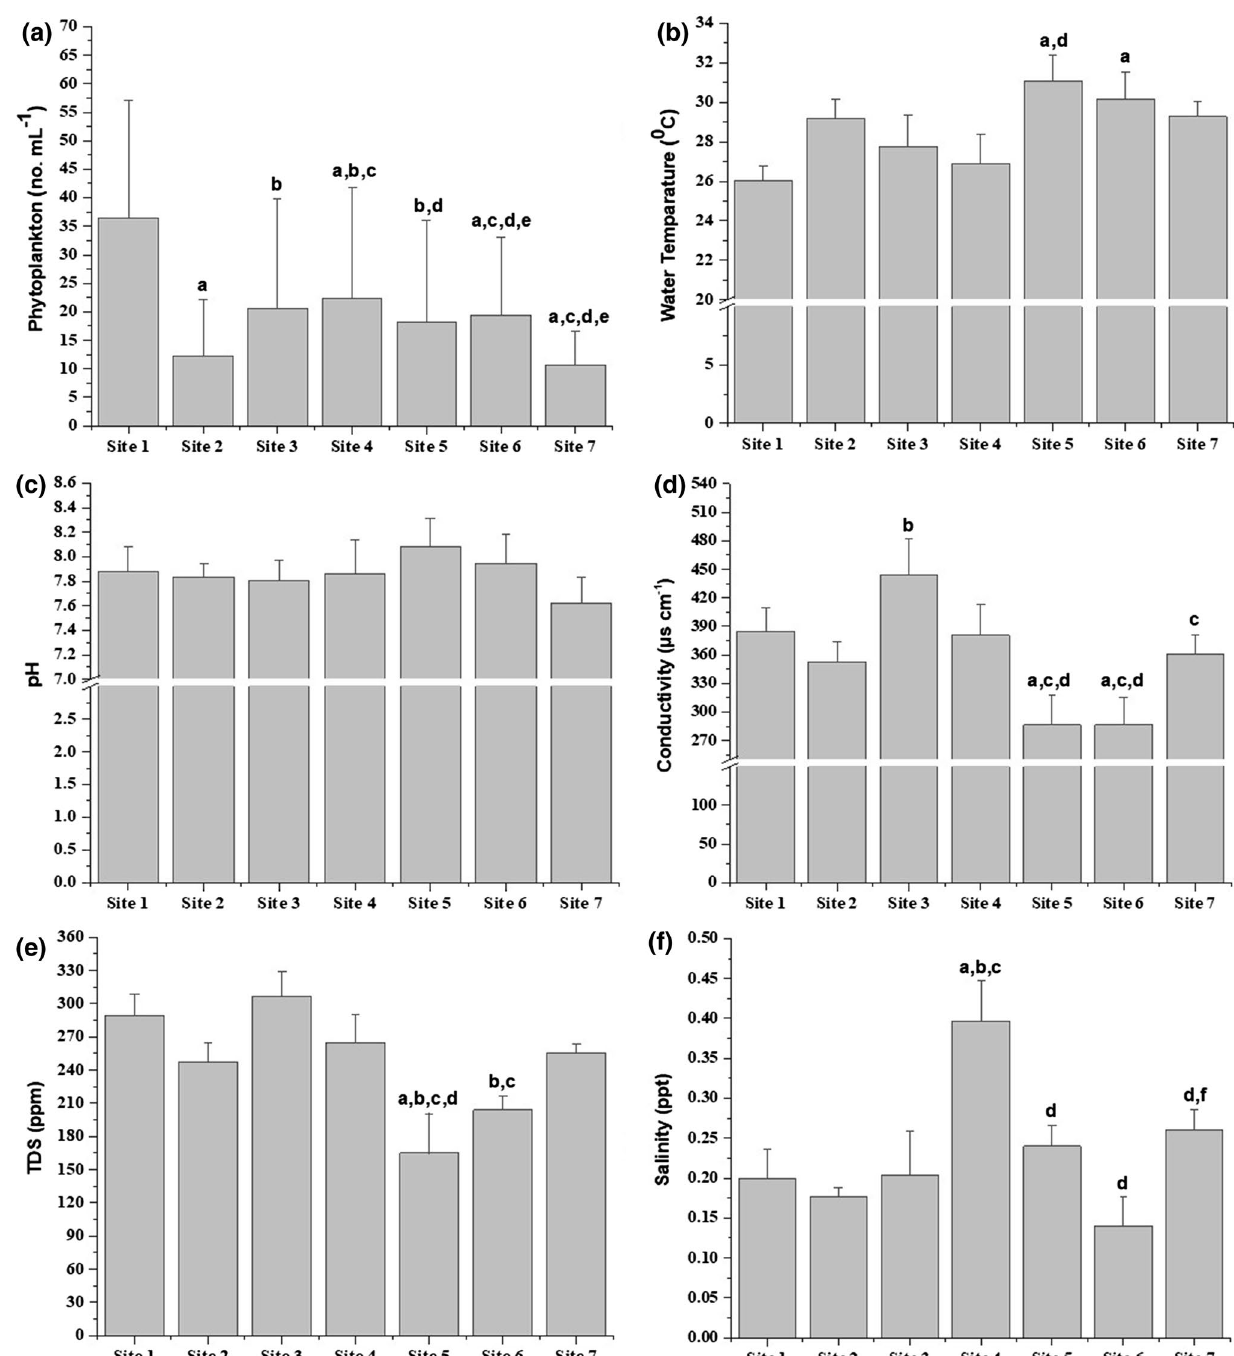
Fig. 5 Phytoplankton assemblage and physicochemical factors at seven selected study sites. By using post hoc analysis (Tukey’s HSD), the site which differs significantly ( p < 0.05) with others sites, marked as follows: a Site 1, b Site 2, c Site 3, d Site 4, e Site 5, f Site